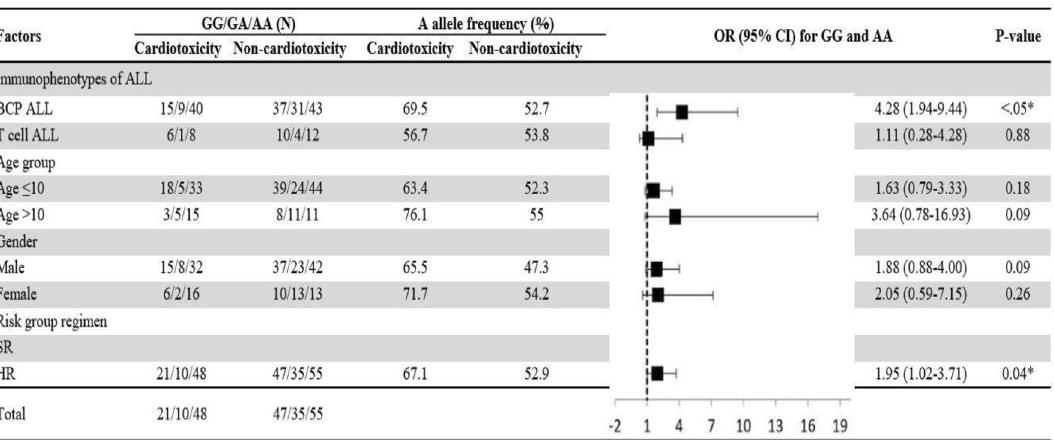
Figure 3. Adjusted association between CBR1 (rs9024) genotypes and risk of